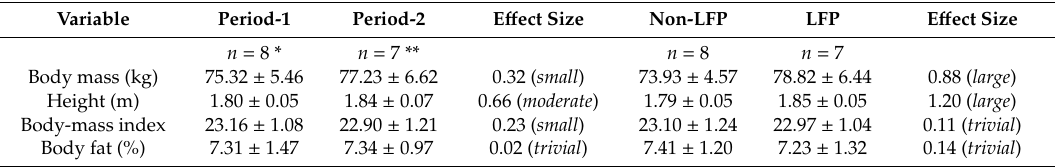
Table 4. Comparison of the anthropometric profile of attackers in Period-1 (2008 / 2009–2012 / 2013) with that of attackers in Period-2 (2013 / 2014–2017 / 2018) and of Spanish non-LFP players with that of Spanish LFP players (2008 / 2009–2017 /